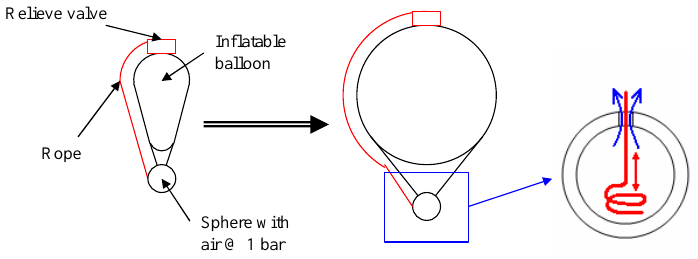
Figure 6. The working principle of the “Auguste Piccard’s